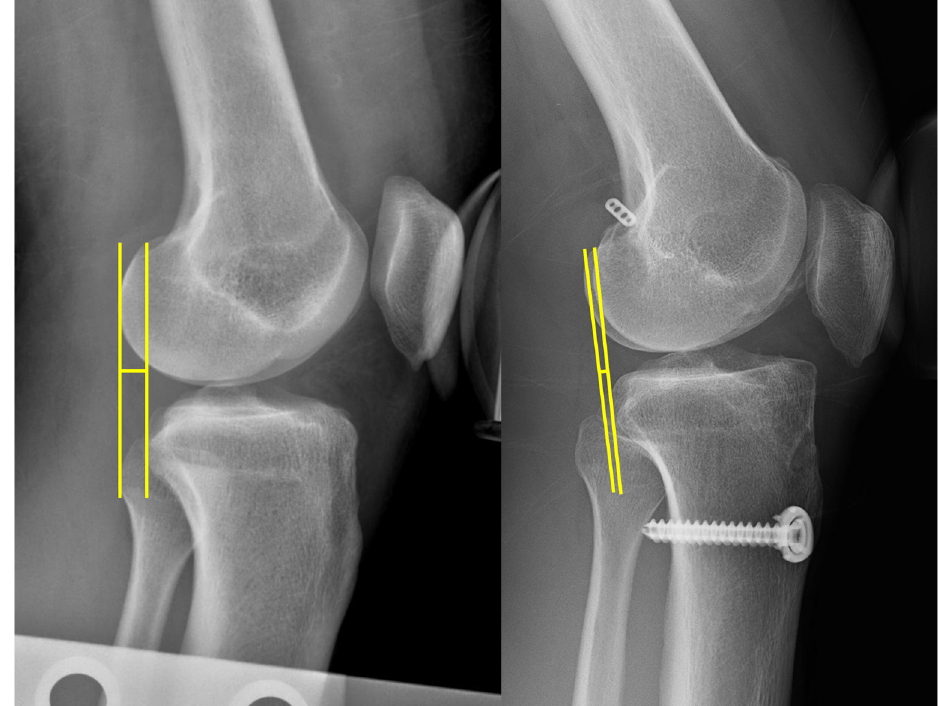
Figure 5. Measurement of preoperative and postoperative anterior tibial translation on anterior stress radiography. (yellow lines) Two perpendicular lines were drawn tangentially to the most posterior contour of the femoral condyle and tibial plateau. Anterior tibial translation was defined as the distance between the two perpendicular lines.